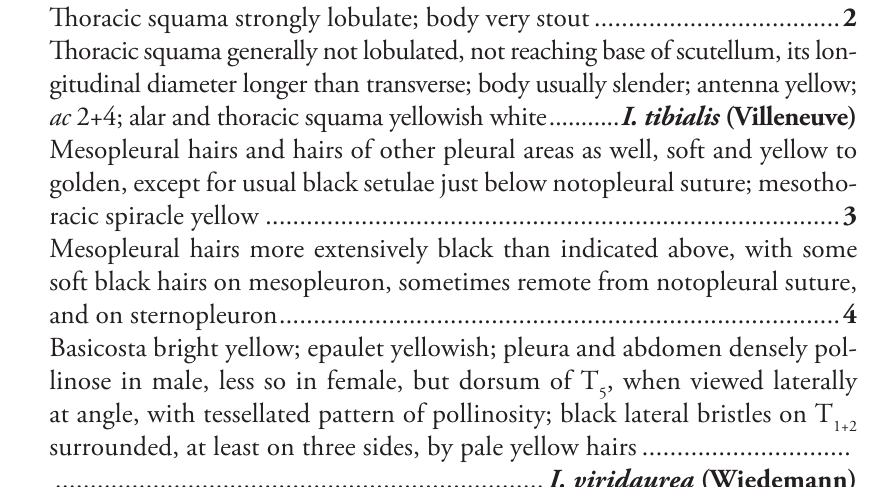
Tribe Cosminini Key to the species of Isomyia 1 Thoracic squama strongly lobulate; body very stout .................................... 2 – Thoracic squama generally not lobulated, not reaching base of scutellum, its lon- gitudinal diameter longer than transverse; body usually slender; antenna yellow; ac 2+4; alar and thoracic squama yellowish white ........... I. tibialis (Villeneuve) 2 Mesopleural hairs and hairs of other pleural areas as well, soft and yellow to golden, except for usual black setulae just below notopleural suture; mesotho- racic spiracle yellow .................................................................................... 3 – Mesopleural hairs more extensively black than indicated above, with some soft black hairs on mesopleuron, sometimes remote from notopleural suture, and on sternopleuron .................................................................................. 4 3 Basicosta bright yellow; epaulet yellowish; pleura and abdomen densely pol- linose in male, less so in female, but dorsum of T , when viewed laterally 5 at angle, with tessellated pattern of pollinosity; black lateral bristles on T 1+2 surrounded, at least on three sides, by pale yellow hairs .............................. ...................................................................... I. viridaurea (Wiedemann) – Basicosta black; epaulet black; T and T without marginal band; wing hya- 3 4 line, sometimes slightly infuscated apically in female; parafrontal in female subequal to frontal stripe at middle of frons; hind tibia without av in male .. .................................................................................... I. electa (Villeneuve) 4 Marginal scutellar bristles ( msc ) 4, the last three spaced at closer intervals than basal bristle; both alar and thoracic squama pale yellow; posterior mesopleural fringe yellow; some hairs on notopleuron, lower part of mesopleuron, and part of sternopleuron yellow to yellowish brown ........... I. pseudolucilia (Malloch) – Marginal scutellar bristles 3, spaced at approximately equal intervals .......... 5 5 Pleura with extensive yellow hairs, at least around pst and propleural bristles ( pp ) and on part of sternopleuron; posterior mesopleural fringe golden ...... 6 – Pleural hairs entirely black or virtually so; posterior mesopleural fringe brown to black; alar and thoracic squama wholly dark brown to black ..................... ..................................................................................... I. oestracea (Séguy) 6 Mesothoracic spiracle entirely bright yellow to golden; T and T without 3 4 marginal band; wing hyaline, sometimes slightly infuscated apically in fe- male; parafrontal in female subequal to frontal stripe at middle of frons; hind tibia without av in male ............................................... I. electa